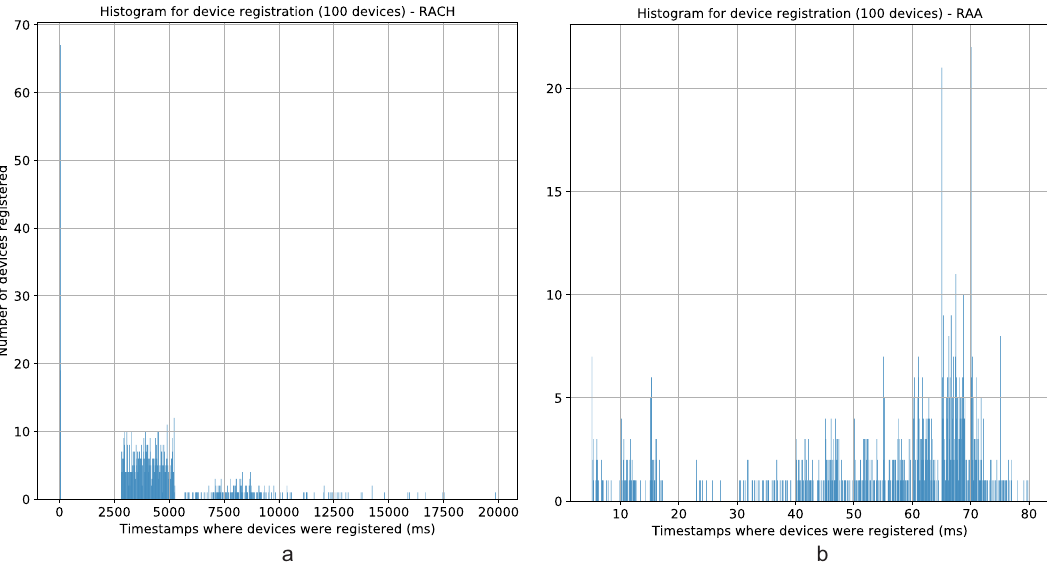
Figure 8. Elapsed time for all devices registration for the classic RACH and four different RAA procedures.